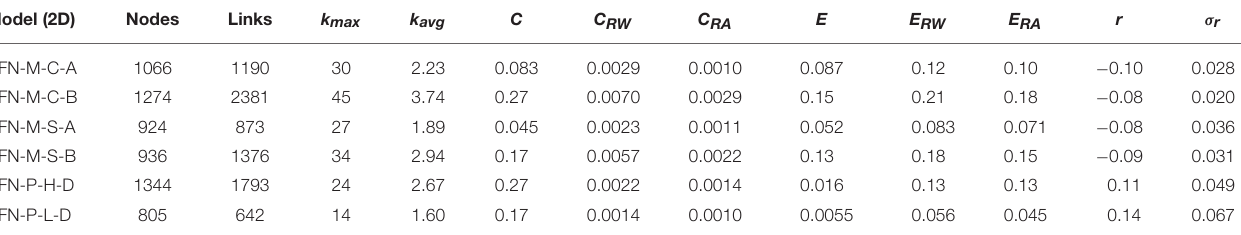
TABLE 1 | Averaged values of the number of nodes, links, maximum degree k max , average degree k avg , clustering coefficient C , clustering coefficient for rewired graphs